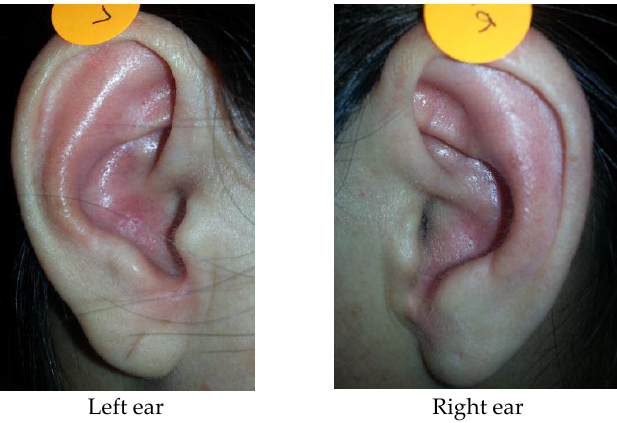
Figure 2. Oily complexion of the auricles in a participant with metabolic syndrome (right and left